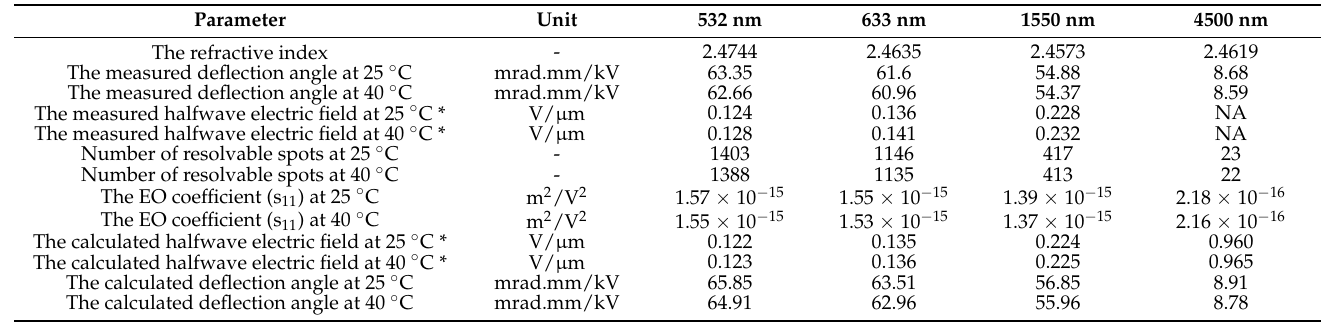
Figure 23. The phase retardance versus applied electric field on PMN-PT ceramic for four wavelengths (532, 633, 1550, and 4500 nm).